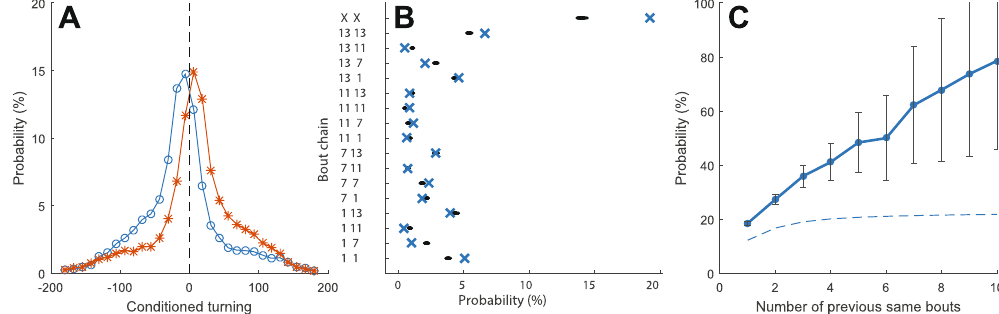
Figure 4. The organization of swimming behavior. Conditioned turning probabilities reveals a tendency to repeat turning in the same direction. Blue curve shows the total turning angle of bouts that directly follow a left turn > 10 degrees and red curves the corresponding data for right turns. ( B ) Examples of how different types of bouts are preferentially performed in certain combinations and orders. Blue crosses denoted the actual probability of observing a given bout pair sequence and black dots represent the expected probability based on the overall frequency of observation of the two bout types making up the pair (constructed from 100 shuffled swimming sequences – note the clear separation between the observed randomized data for several of the pairs; The (X-X) sub-chain (top row) is the sum of probabilities for (1-1), (2-2), (3-3), etc.). ( C ) Swimming bouts of a given type tend to be concatenated into longer sequences of repetitive actions. The probability of observing one of the 15 types of swimming bouts is shown as a function of the number of previous observations of the same bout in a row. The theoretical probabilities of the corresponding memoryless system with the same bout class distributions as the actual data are plotted as a dashed line. Error bars represent